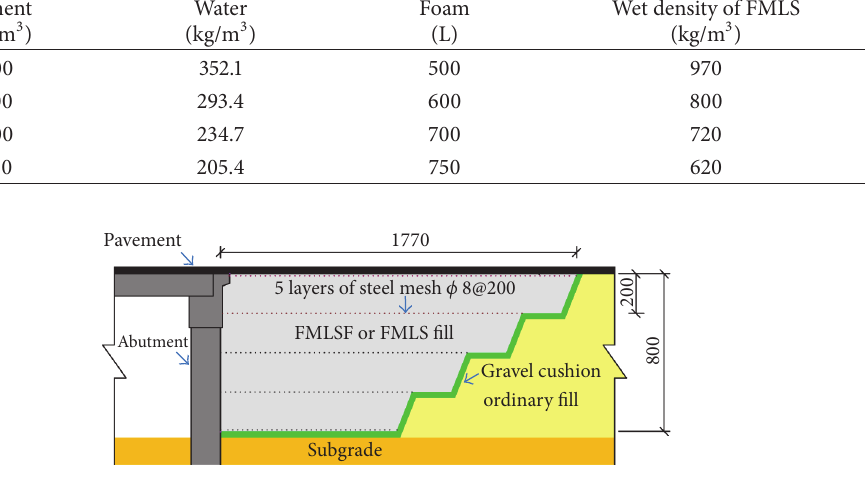
Figure 10: Filling diagram of FMLSF or FMLS as backfill material behind